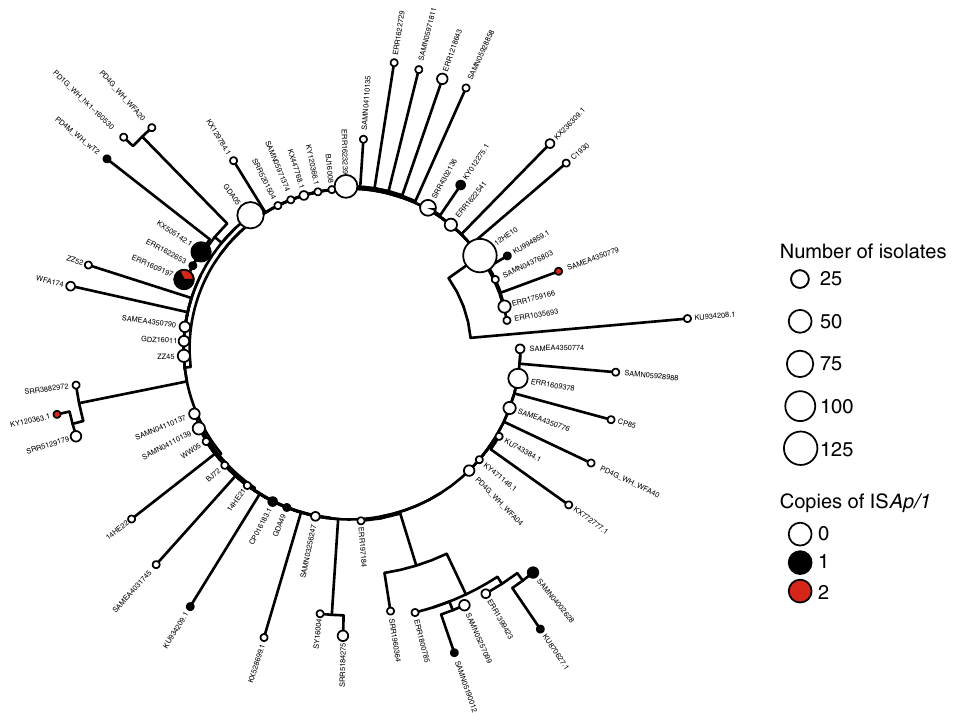
Fig. 4 Phylogeny of the mcr-1 composite transposon indicates a dominant sequence type with subsequent diversi fi cation. Midpoint-rooted maximum parsimony phylogeny based on the 3522 bp alignment of 457 sequences (recombinant regions removed). Size of points indicates the number of identical sequences, with a representative sequence for each shown next to each tip